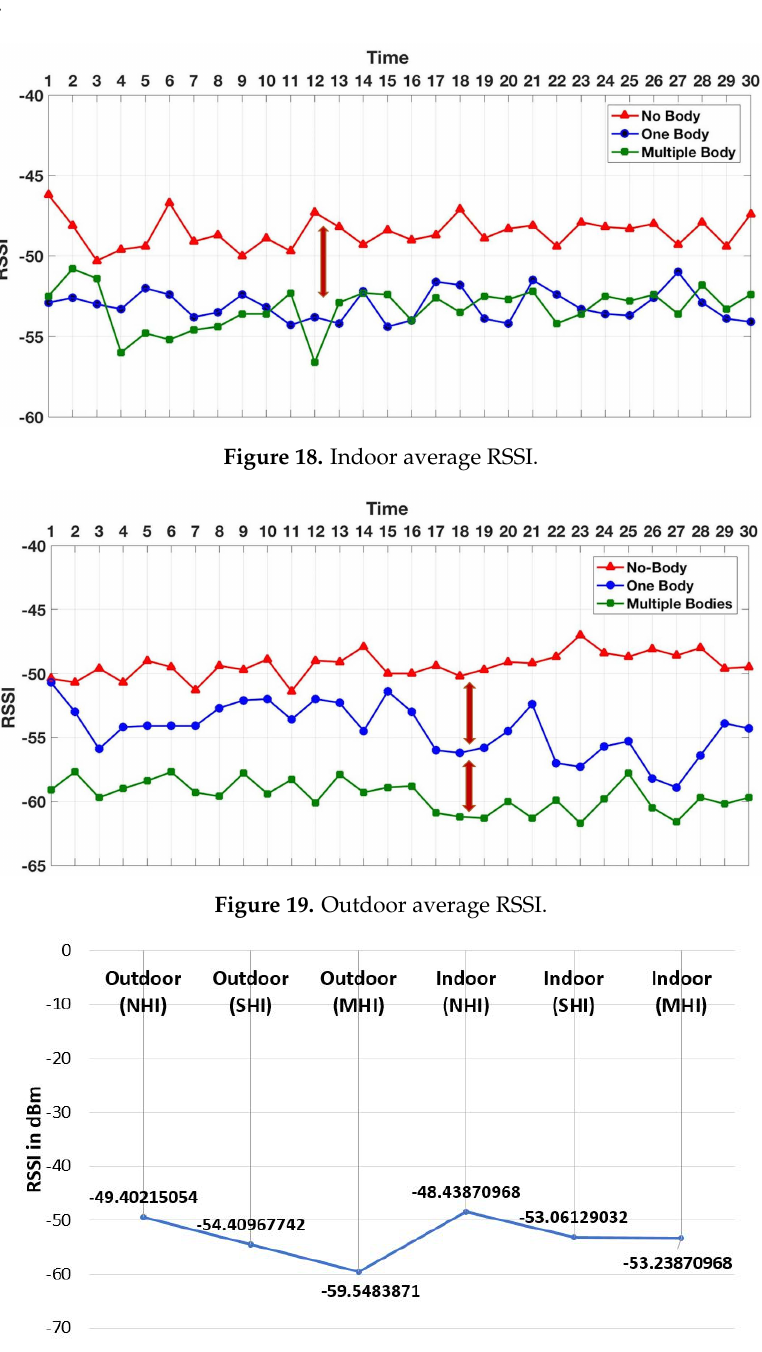
Figure 20. Average RSSI